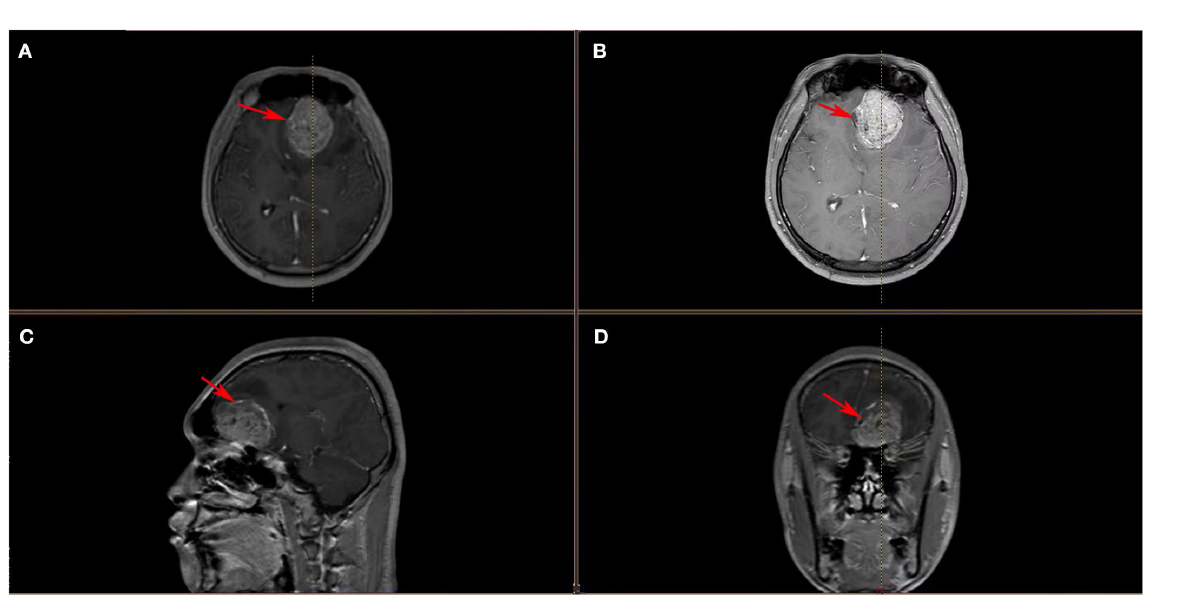
FIGURE1 (A–D) Head MRI images showed a space-occupying lesion in the left frontal lobe with heterogeneous enhancement of the mass, surrounding edema, right-lateral midline structure, compression narrowing of the lateral ventricle, and shallowing local sulci and cistern (these red arrows indicate